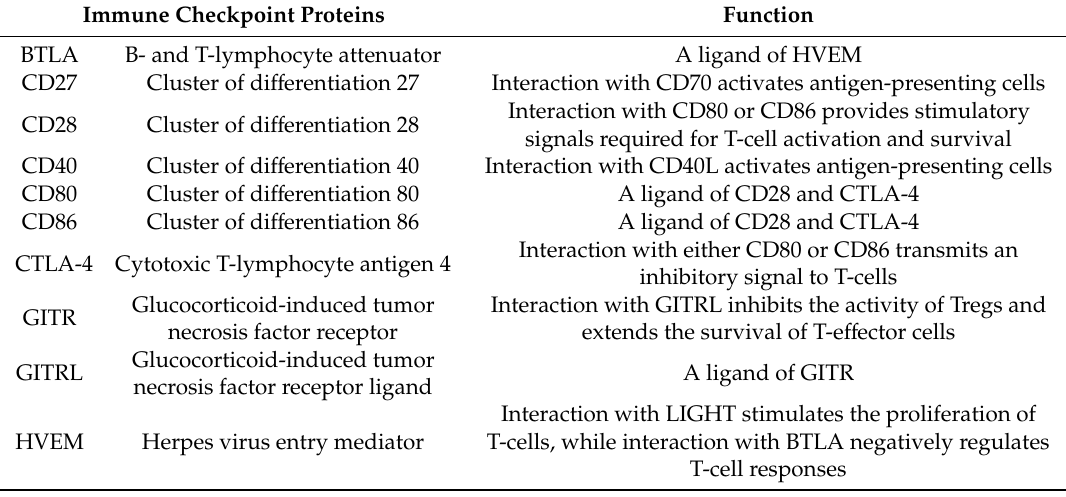
Table A1. The 16 immune checkpoint proteins whose soluble forms were analyzed in this study. Immune Checkpoint Proteins Function